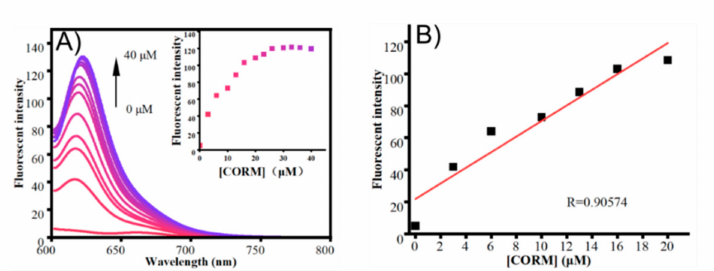
Figure 5. ( A ) Fluorescent spectra changes of probe TCF-ether (50 µ M) in the presence of PdCl 2 (50 µ M) upon the addition of different concentrations of CORM-2 in PBS buffer (10 mM, pH 7.4, with 30% DMSO, v/v ) at 37 ◦ C. Insert: fluorescence intensity changes of the probe system at 618 nm as a function of the concentrations of CORM-2. ( B ) Linear correlation between emission intensity and concentration of CORM-2 (0–20 µ M) at 618 nm. Each spectrum was obtained 15 min after mixing. λ ex = 580 nm.